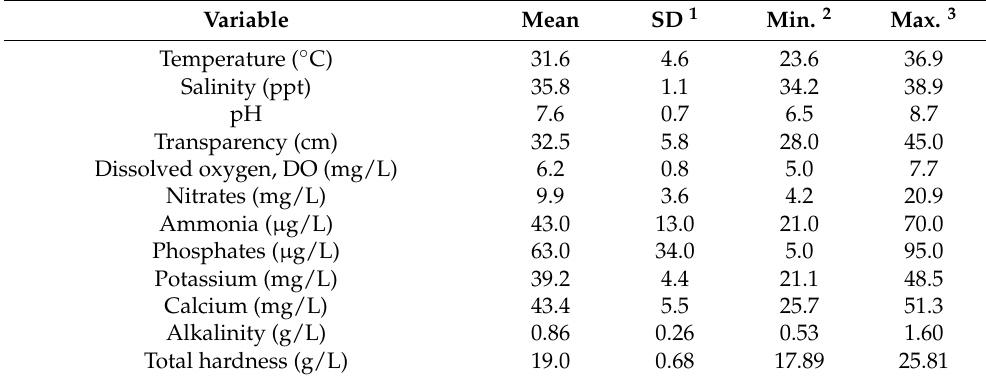
Table 3. Yearly variability of physicochemical parameters of seawater ponds at Garho Fish Farm.